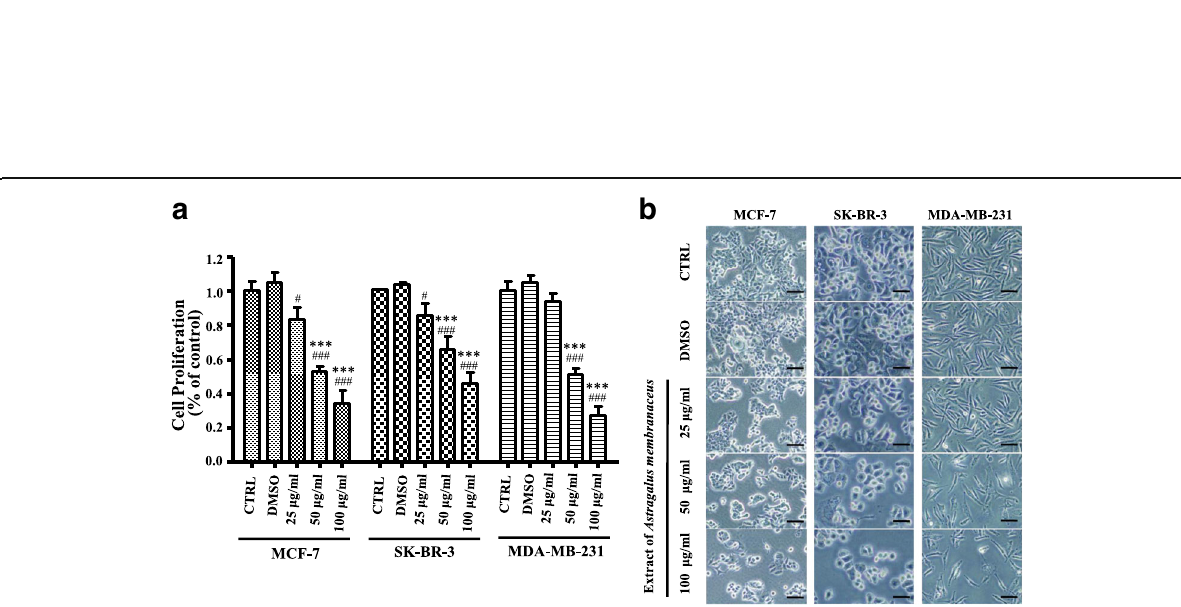
Fig. 3 Cytotoxic effects of AM extract on three distinct breast cancer cell lines. a After treated with different concentration of AM extract for 48 h, the cell proliferation was evaluated with MTT assay. Values are the mean ± S.D. of triplicate determinations of three independent experiments. *** p < 0.001, compared with blank control group (CTRL); # p < 0.05, ### p < 0.001, compared with DMSO group. b Morphological effect of AM extract on breast cancer cells